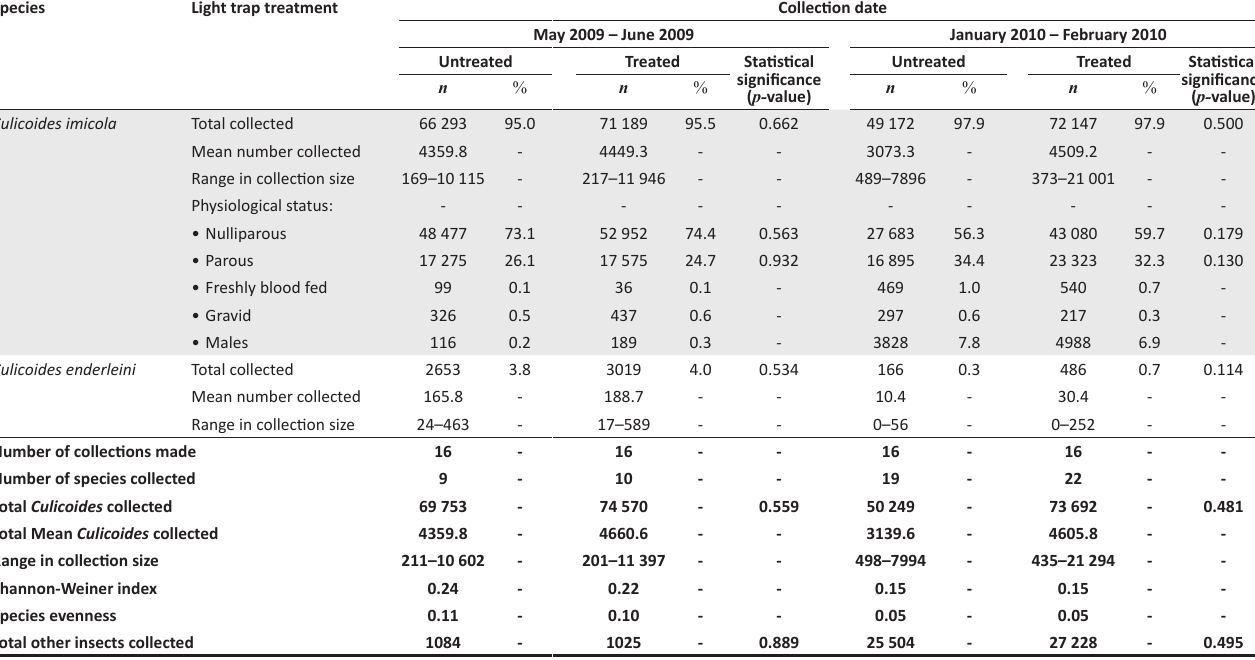
TABLE 1: Summary of the Culicoides midges collected with white light suction traps in two trials at the Agricultural Research Council-Onderstepoort Veterinary Institute to determine the effect of a combination of citronella and lemon eucalyptus oil on Culicoides numbers, species composition and physiological status of the population.